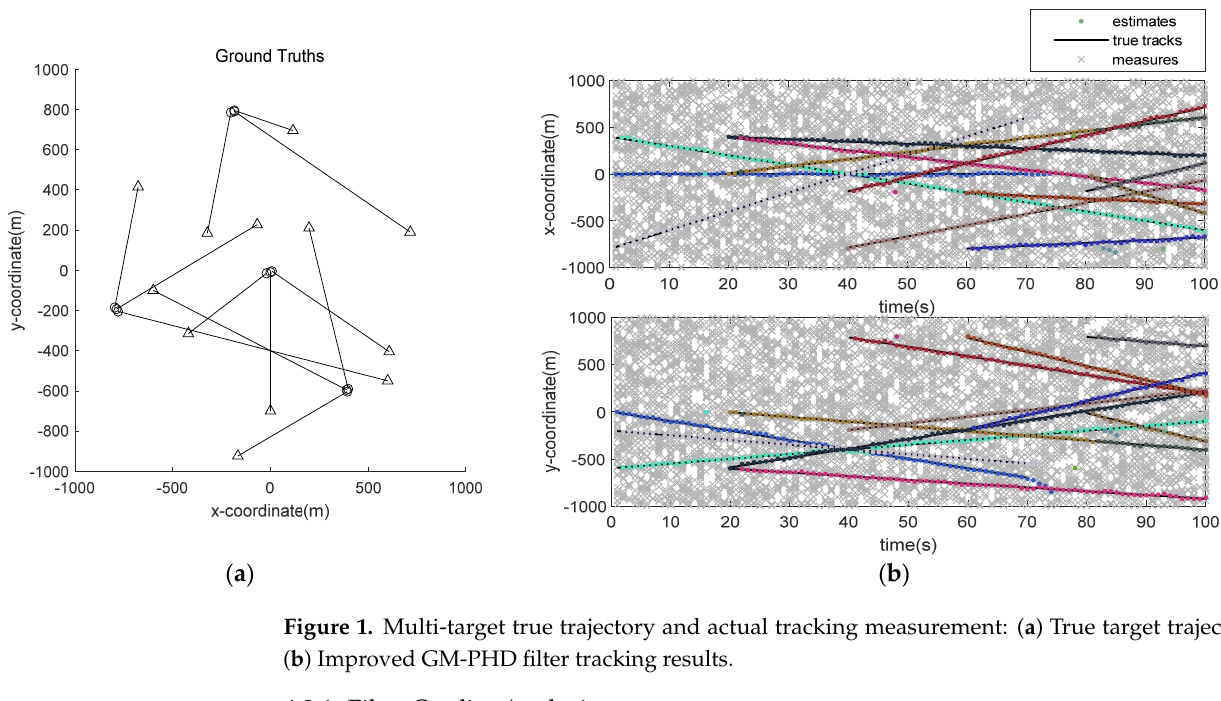
Figure 1. Multi-target true trajectory and actual tracking measurement: ( a ) True target trajectory; ( b ) Improved GM-PHD filter tracking results.